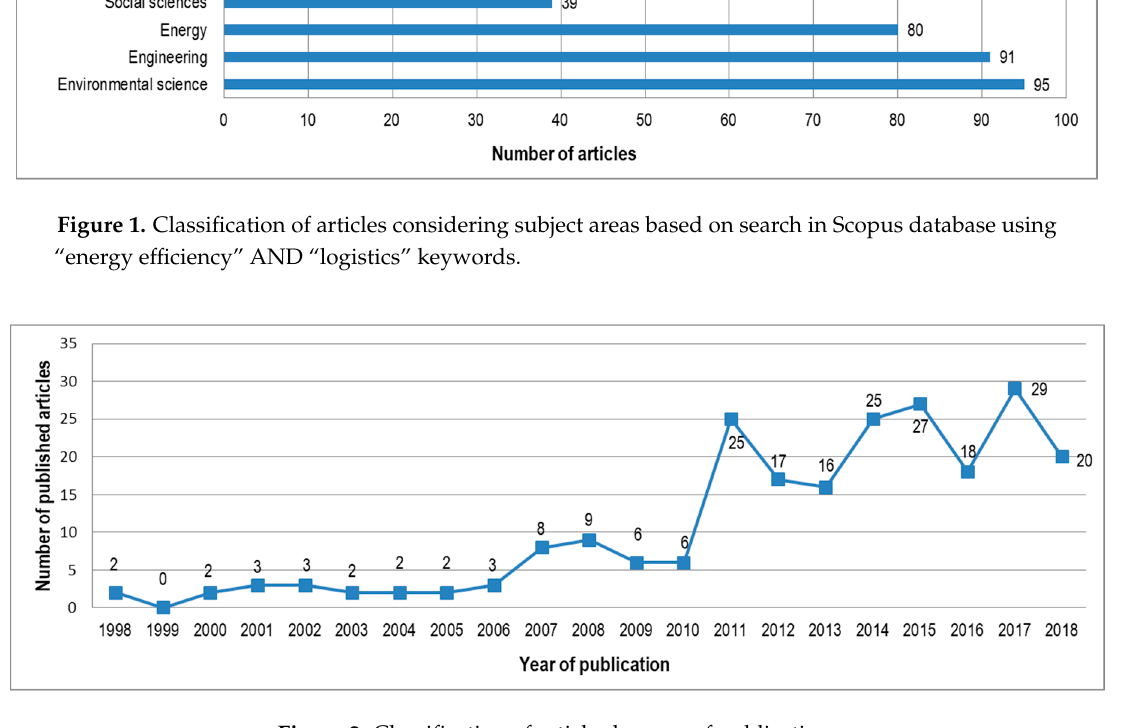
Figure 1. Classification of articles considering subject areas based on search in Scopus database using “energy efficiency” AND “logistics” keywords.